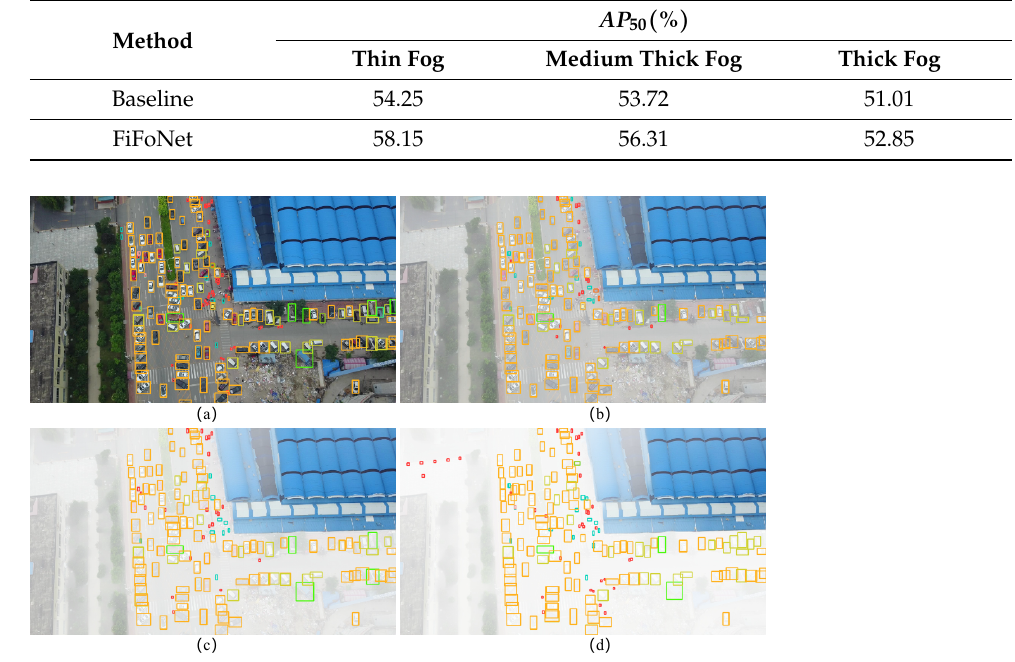
Figure 12. Visualization of the results obtained with our FiFoNet on the clean image ( a ), the thin ( b ), medium thick ( c ), and thick ( d ) fog